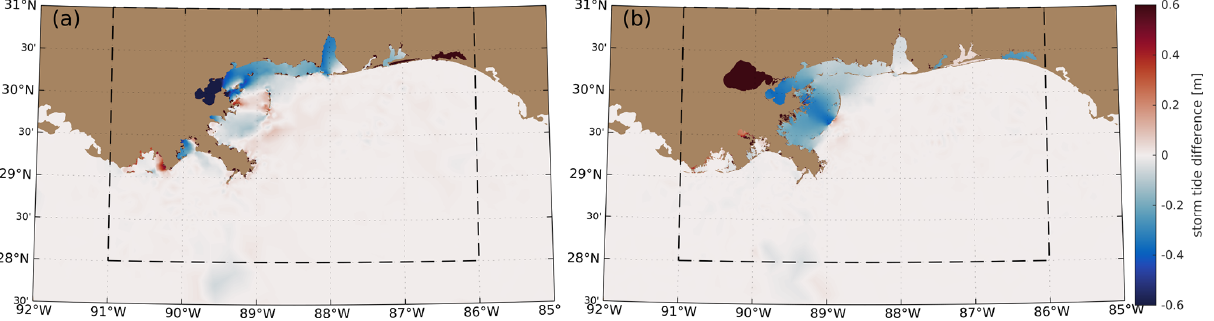
Figure 12. Mesh-resolution-induced differences in the simulated maximum storm tide elevations due to Hurricane Katrina in the Louisiana– Mississippi landfall region. (a) Elevations on the MinEle = 500m local refinement mesh minus elevations on the TLS-B global mesh (MinEle = 1.5km). (b) Elevations on the MinEle = 150m local refinement mesh minus elevations on the MinEle = 500m local refine- ment mesh. In areas where the coarser-resolution mesh does not exist the value shown is just the maximum storm tide elevation on the higher-resolution